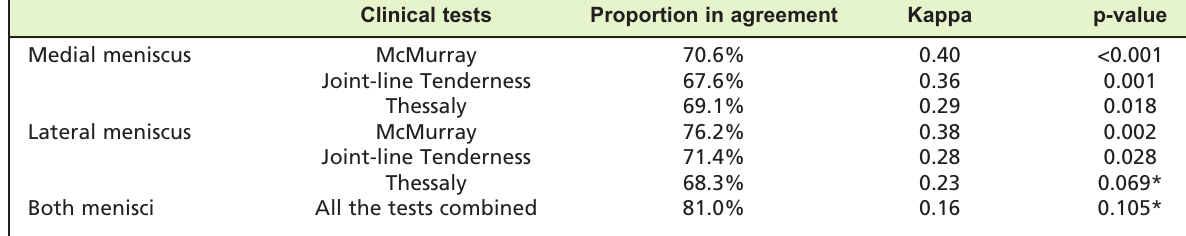
Agreements between the results of the clinical tests and Table III: